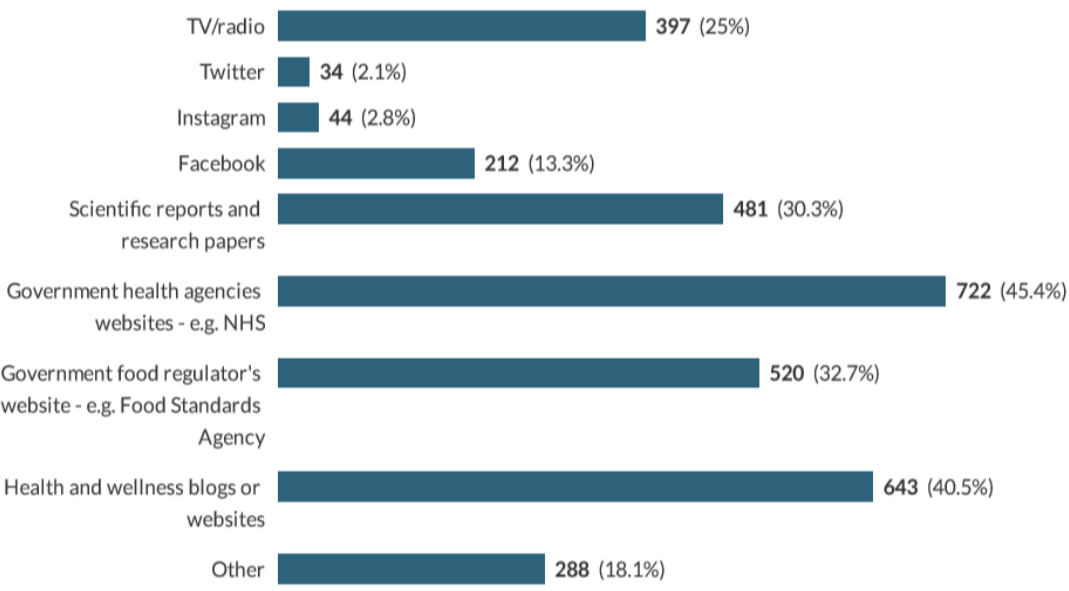
Figure 3. Sources of respondents’ knowledge of benefits and safety of NNS. NHS: National Health service. Table 3. Knowledge of regulations surrounding the use of artificial